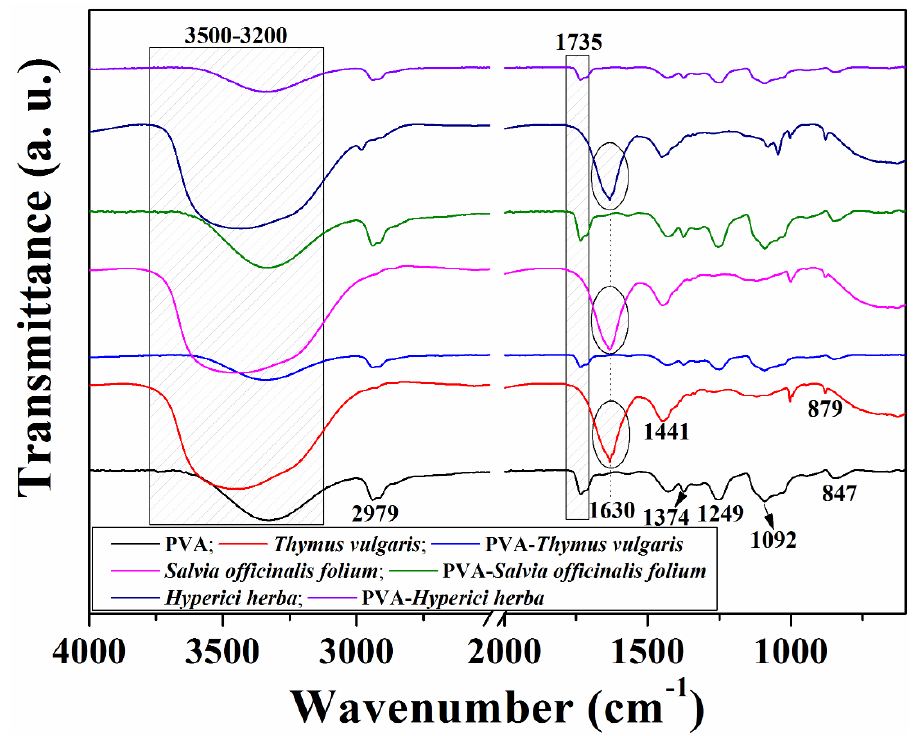
Figure 2. FTIR spectra of electrospun PVA fibers and PVA fibers loaded with corresponding phytotherapeutic agents in hydroalcoholic solutions.